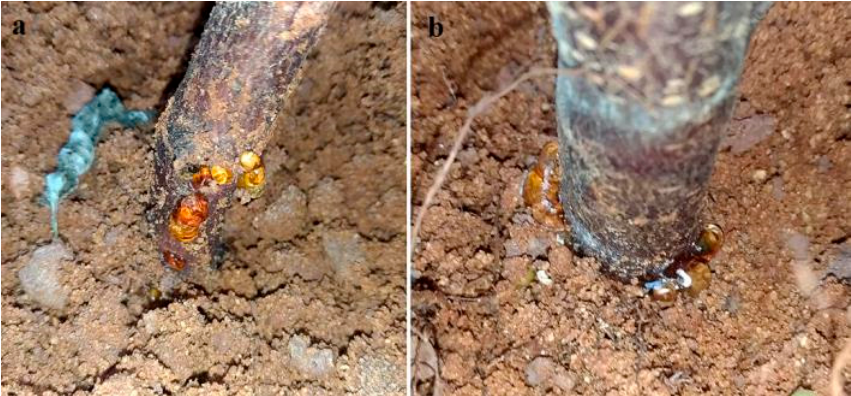
Figure 5. Gumming at the rootstock base 15 days after larval release: ( a ) detail of the trunk base without adhering soil; ( b ) detail of the trunk base and gum secretion at the level of the